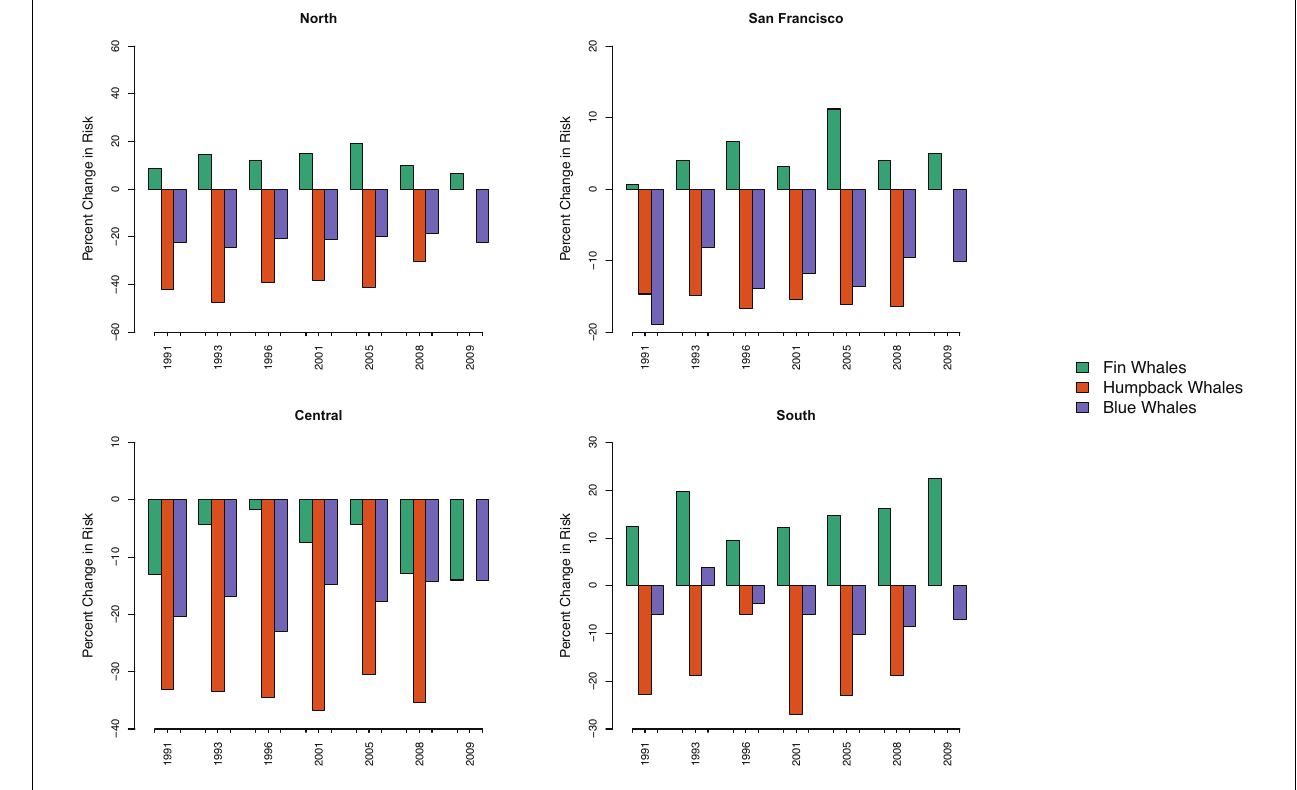
FIGURE 5 | We assessed the effect of interannual variability in whale distributions on ship-strike risk using the percent change between risk for the nearshore versus offshore traffic scenarios; the x -axes represent years in which marine mammal surveys were conducted. Negative values indicate a decrease in mean risk from the offshore, compared to the nearshore, traffic scenario. Whether the nearshore traffic scenario poses a higher ship-strike risk than the offshore traffic scenario in each region is consistent across all years for each species, except the 1993 blue whale predictions in the southern region.